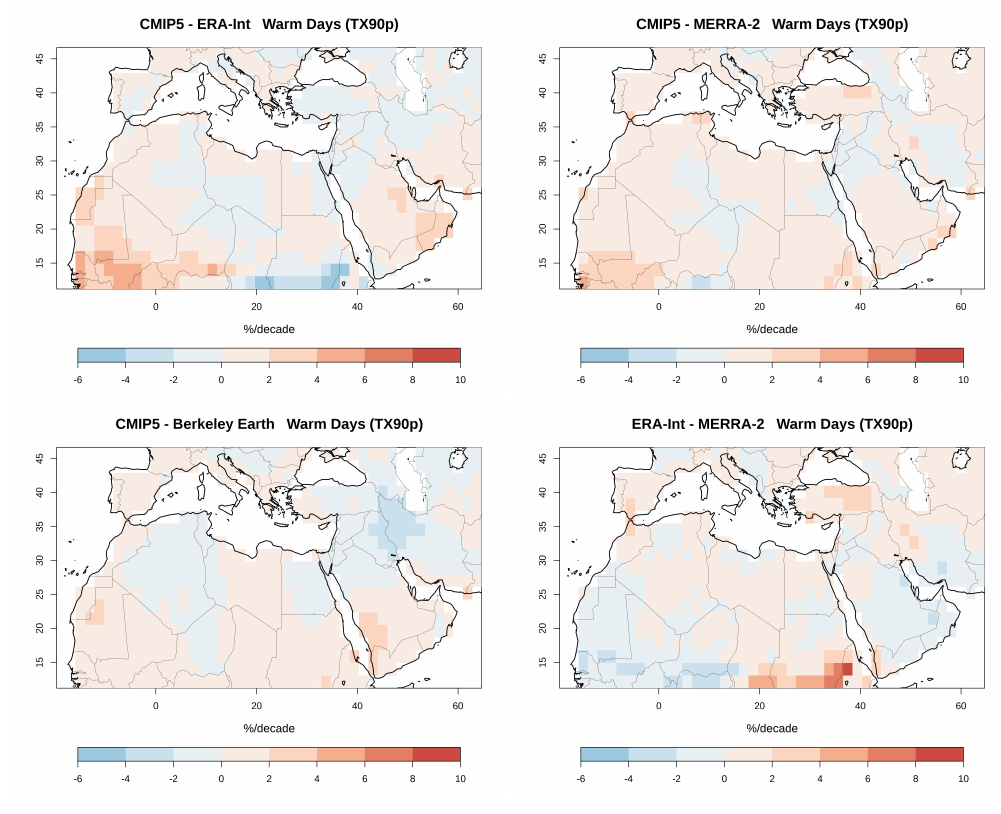
Figure A8. Same as Figure A5 but for the Warm Days (TX90p).